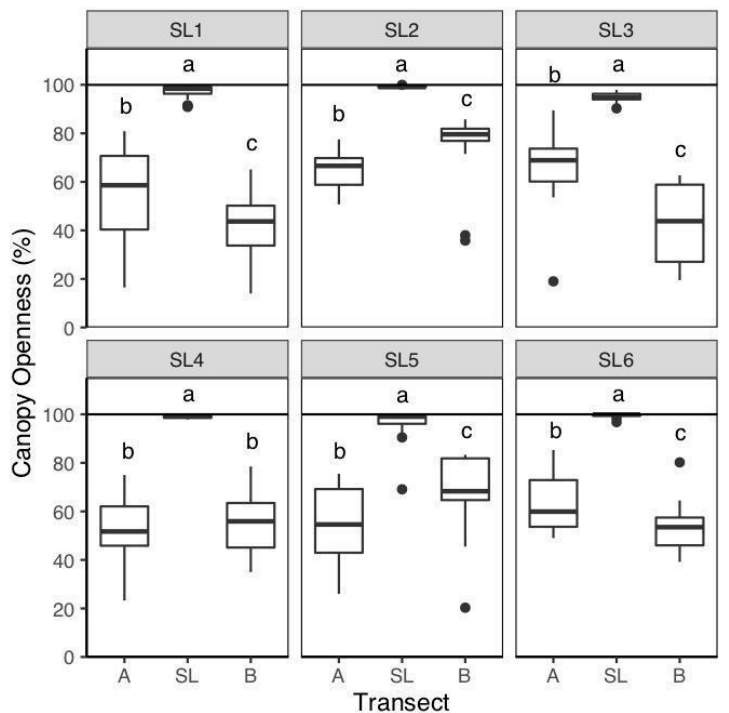
Figure 2. Canopy gap fraction at each site. Transects ‘A’ and ‘B’ are located in the adjacent peatland to the ‘SL’ transect. Letters indicate significant ( p < 0.01) di ff erences in canopy gap fraction between transects at each site, with no comparison amongst sites.